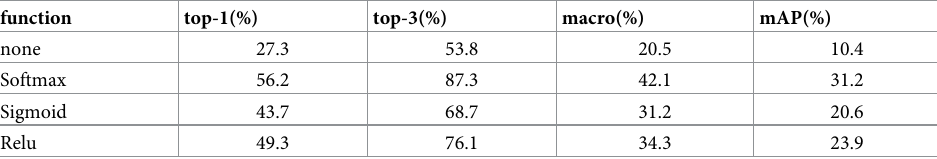
Table 6. Comparison of Softmax with other activation functions.